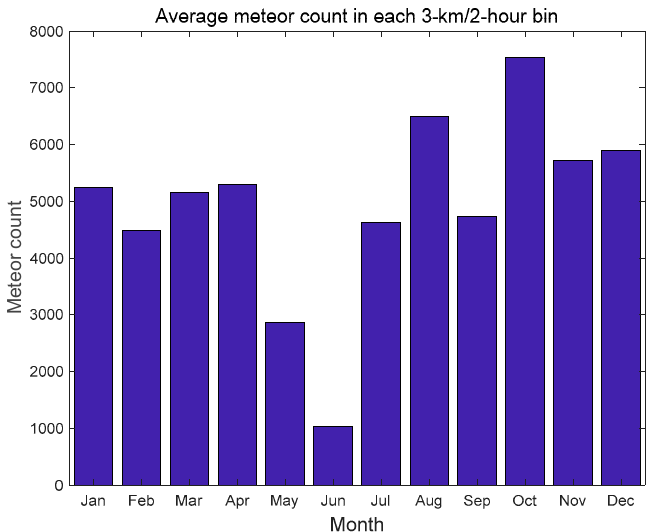
Figure 9. Average meteor counts for each 3-km and 2-h bin on composite days in each calendar month, including all data from 1 July 2010 to 31 July 2011.